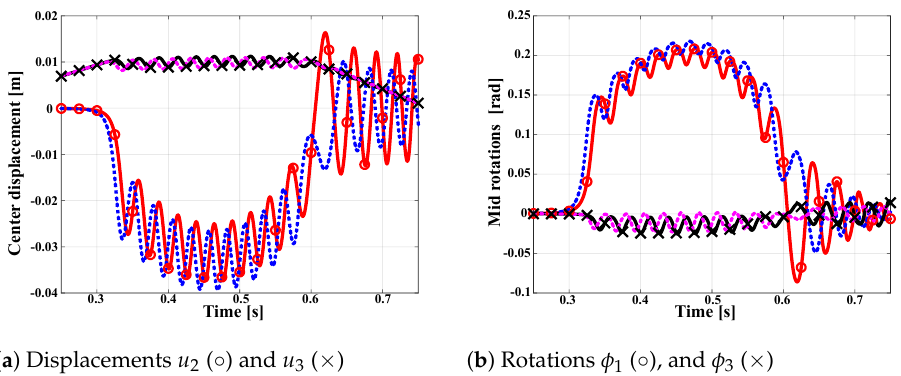
Figure 16. Center-point displacement and rotation: plate model (solid line); beam model (dashed line).